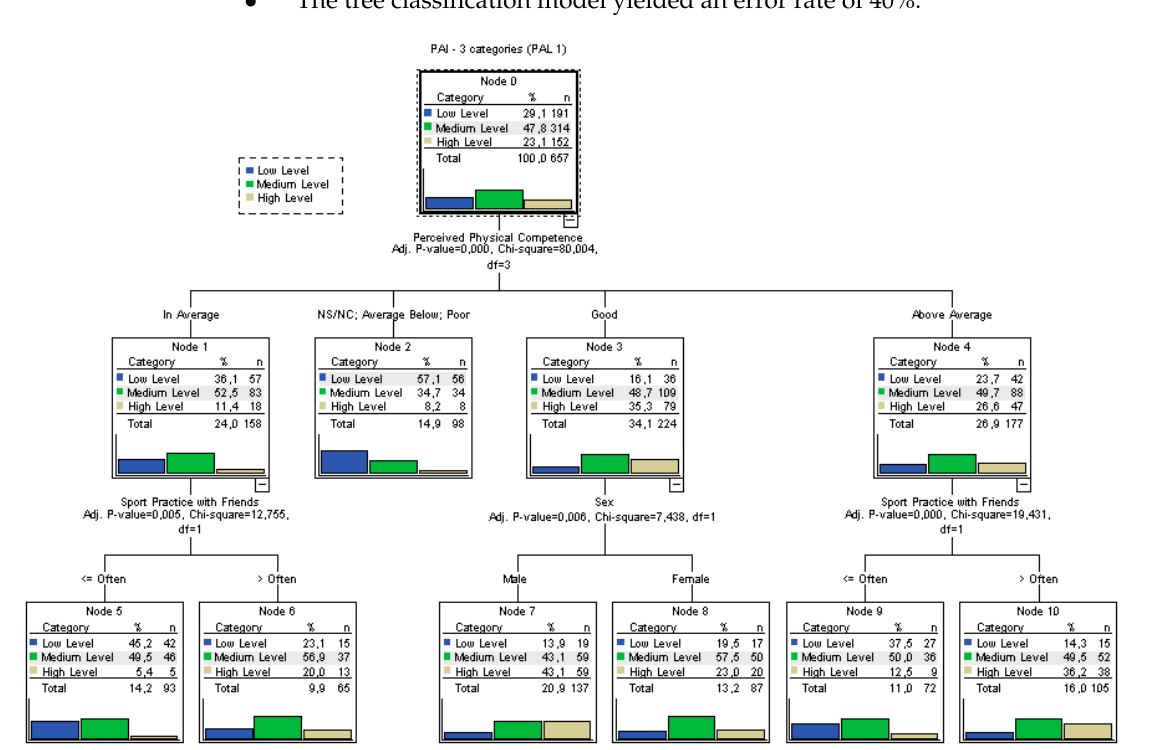
Figure 2. Classification tree for the variable PAL1.